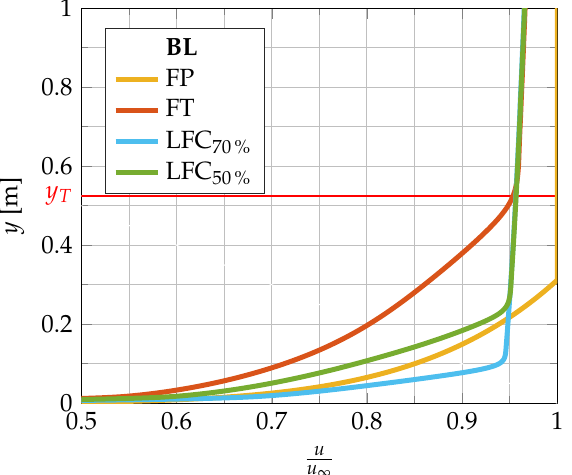
Figure 7. Boundary layer velocity for the considered cases at engine position x / l = 0.9 and position y T of fan tip relative to the wall (see Section